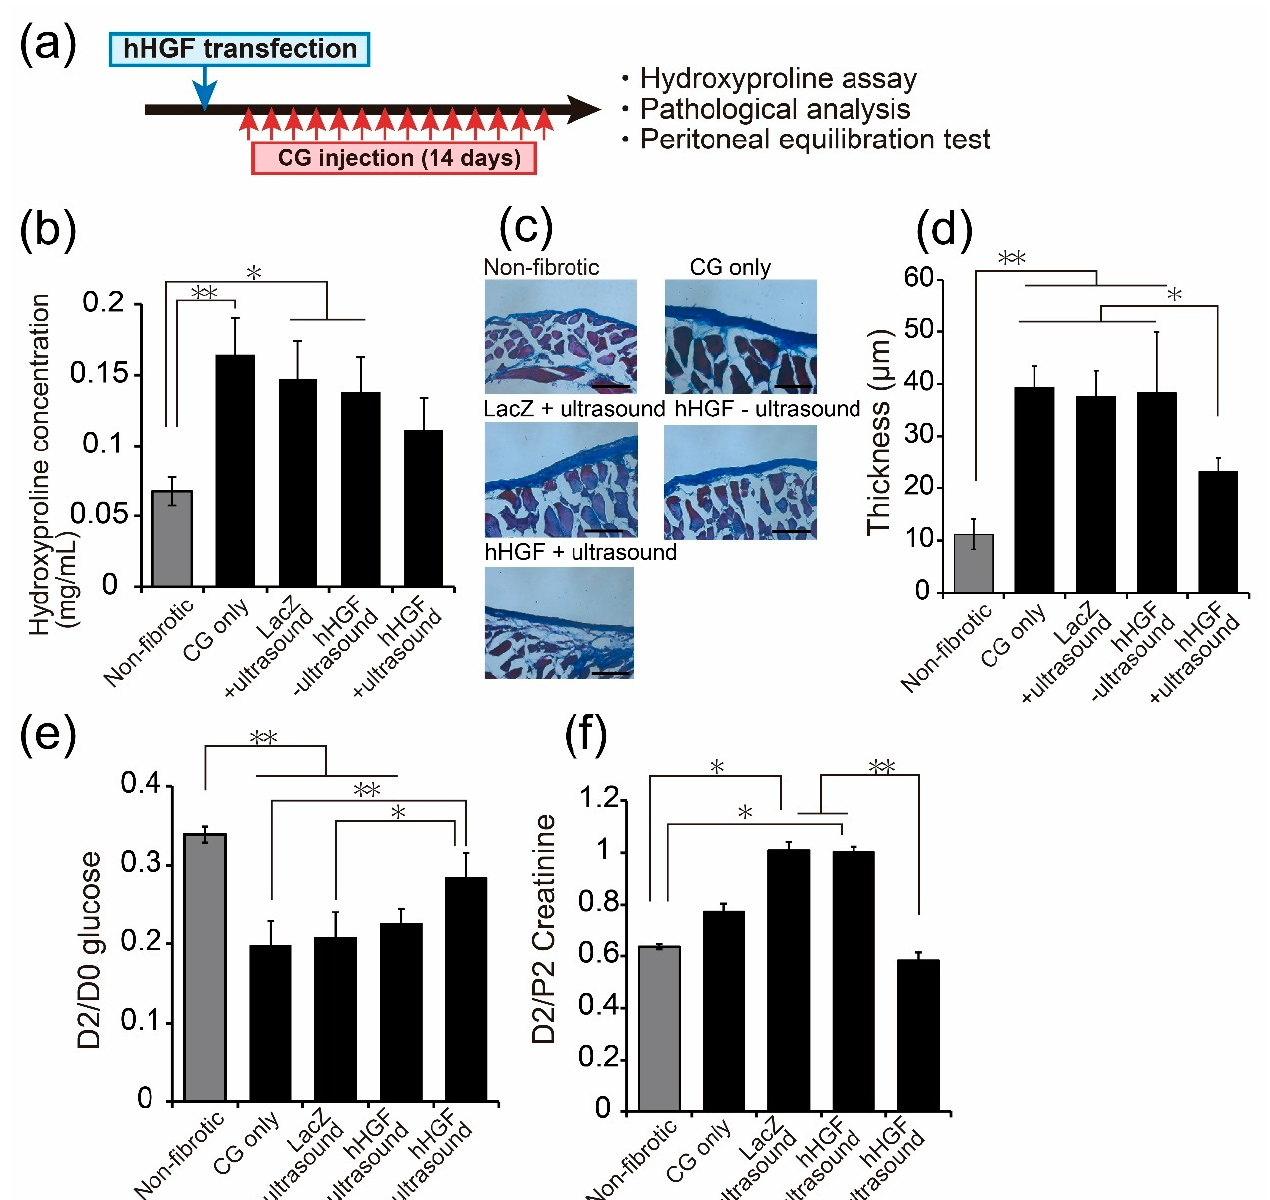
Figure 2. Prevention effects of the progression of CG-induced peritoneal fibrosis by sonoporation-mediated hHGF trans- fection. ( a ) Experiment schedule. Mice were transfected hHGF and injected CG for 14 days from the following day of transfection. ( b ) The hydroxyproline concentration in the peritoneal wall ( c ) Masson’s trichrome staining of the peritoneal wall. Scale bar represents 100 µm. ( d ) The thickness of the submesothelial layer. Data are represented as mean ± SD ( n = 3). ( e , f ) The peritoneal absorption of glucose and creatinine from the dialysate (peritoneal fluid 2 h (D2)/D0) glucose and the dialysate-to-plasma ratio (D2/plasma 2 h (P2)) creatinine were examined by peritoneal equilibration test. Values are expressed as the mean ± SD ( n = 3–4). * p < 0.05, ** p < 0.01 by Tukey’s multiple comparison